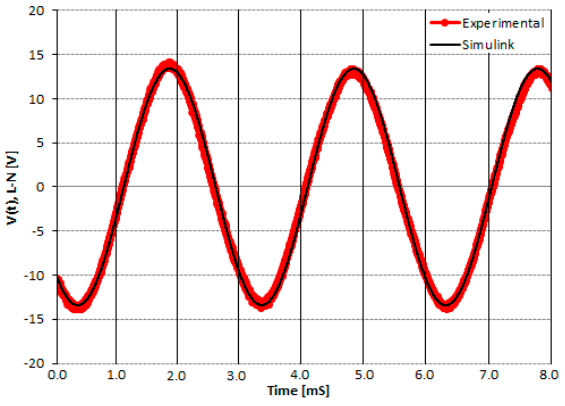
Figure 20. AFPMA no load voltage (line-neutral) experimental results vs. simulation results at N m = 5000 RPM.